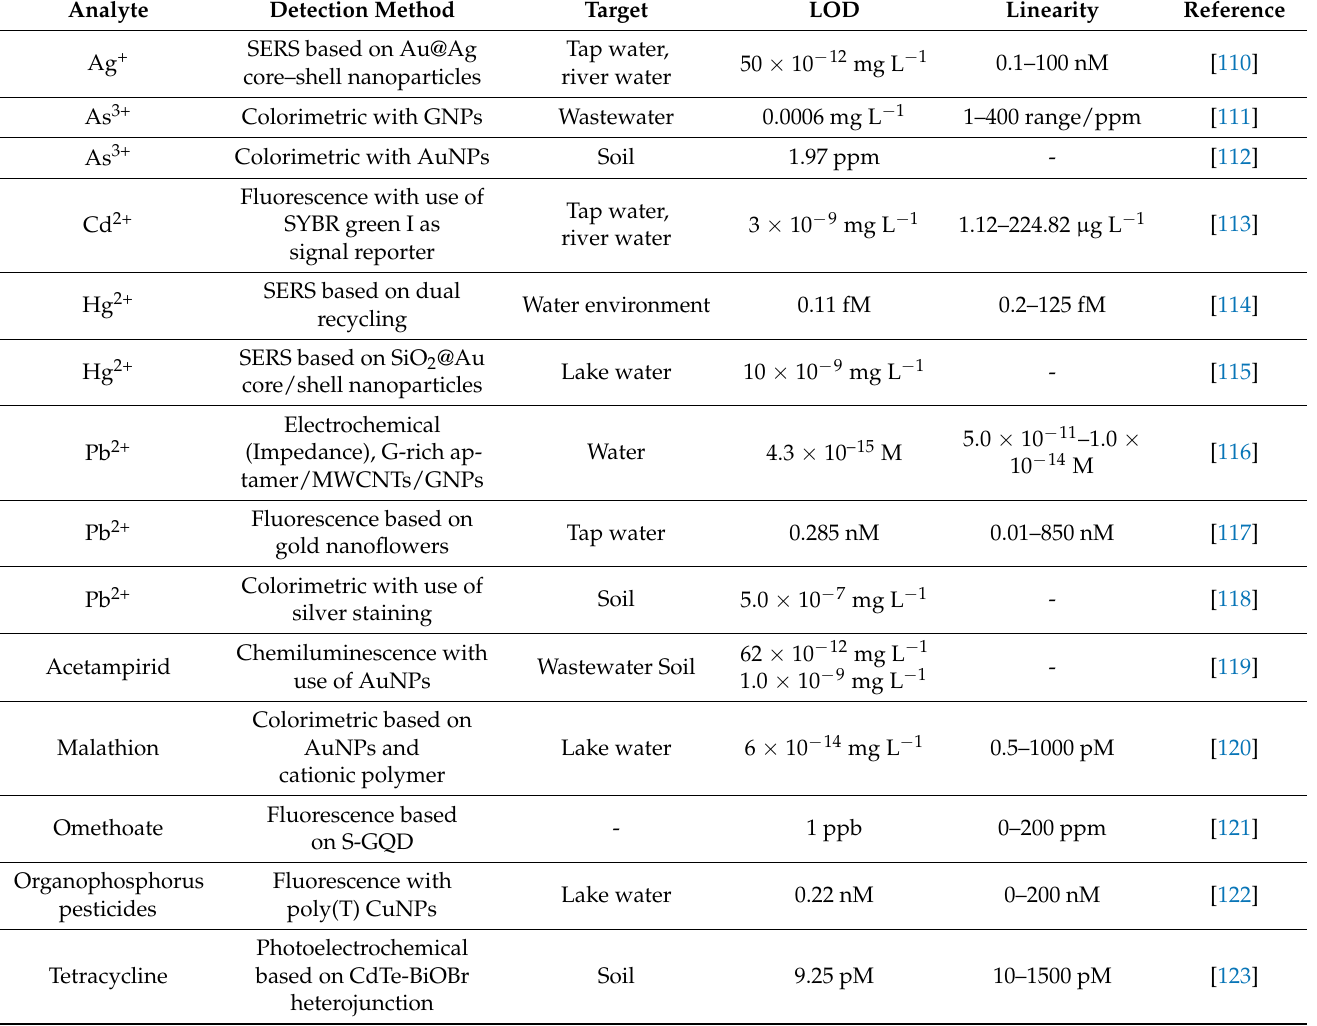
Table 5. Examples of aptamer-based biosensors used for environmental